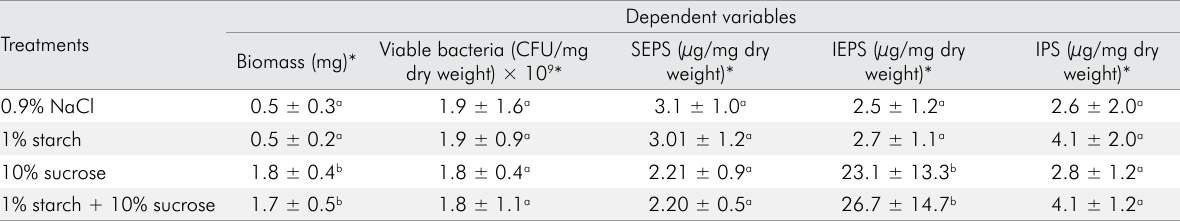
Table 1. Composition of biofilms formed on enamel subjected to the indicated treatments (mean ± SD, n = 9) Treatments